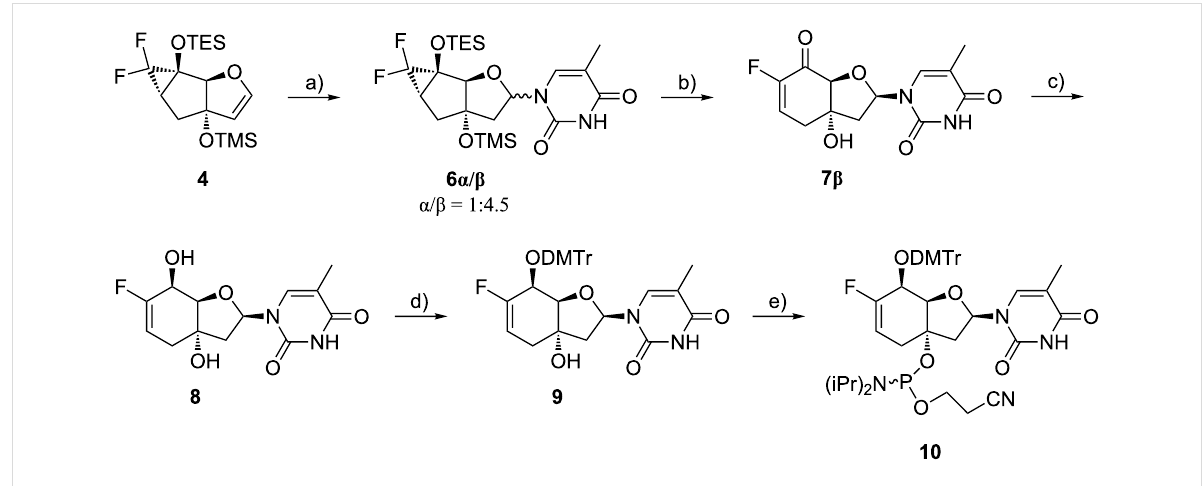
Scheme 2: Synthesis of the thymidine phosphoramidite building block 10 . Reagents and conditions: a) i) thymine, BSA, NIS, DCM, 0 °C to rt, 4.5 h; ii)